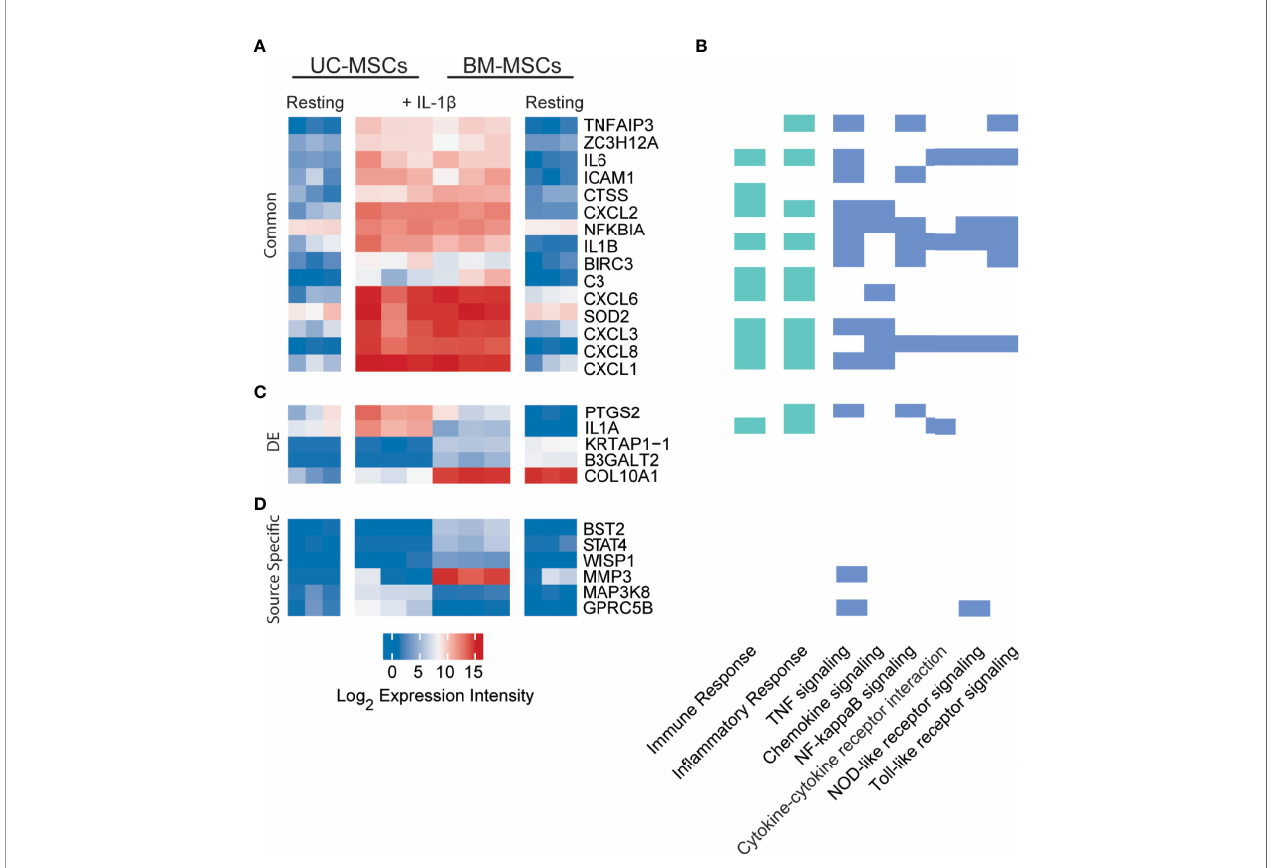
FIGURE 3 | Expression pro fi les of IL-1 b licensed UC and BM-MSCs include 15 common genes and 6 source-imprinted genes. (A) Fifteen genes are signi fi cantly upregulated to comparable levels in UC and BM-MSCs activated by IL-1 b . (B) Genes responsive to IL-1 b are involved in many immune and in fl ammatory processes, as determined by GO (green; see complete enriched list in Table S4 ), as well as 6 enriched KEGG pathways (blue) (p<0.05). (C) Only 5 of the 74 genes DE between unstimulated UC and BM-MSCs are still expressed at signi fi cantly levels after dosing with IL-1 b . (D) Four genes are speci fi cally upregulated in IL-1 b licensed BM-MSCs, while 2 genes are speci fi cally upregulated in IL-1 b activated UC-MSCs. BM, bone marrow; DE, differentially expressed; IL, interleukin; MSC, mesenchymal stromal cell; UC, umbilical